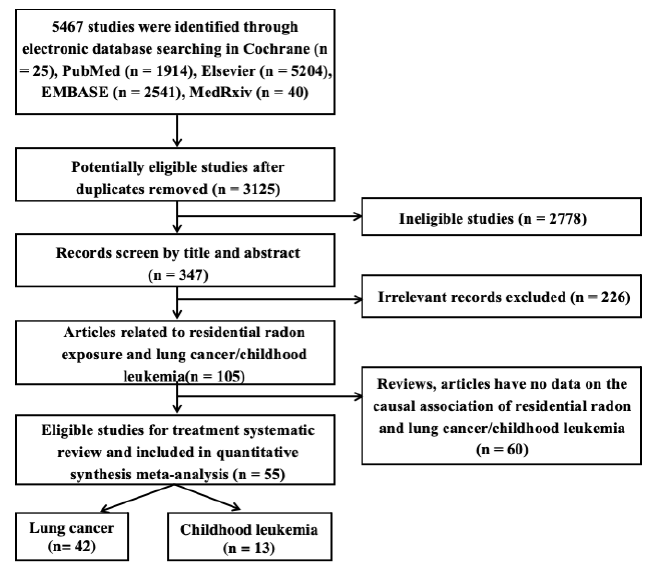
Figure 1. Systematic screening stages of literature review.